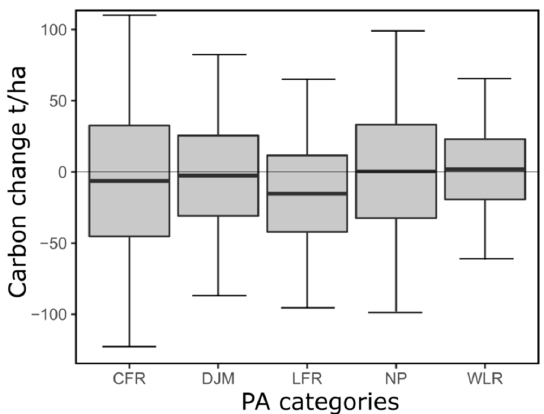
Figure 3. Area-weighted mean (dark horizontal lines of each box) of carbon change (t/ha) (2000–2012) of the five management categories. The upper and lower limits of the boxes are the 75th and 25th percentile, respectively, while that of the whiskers is the maximum and minimum values excluding outliers.